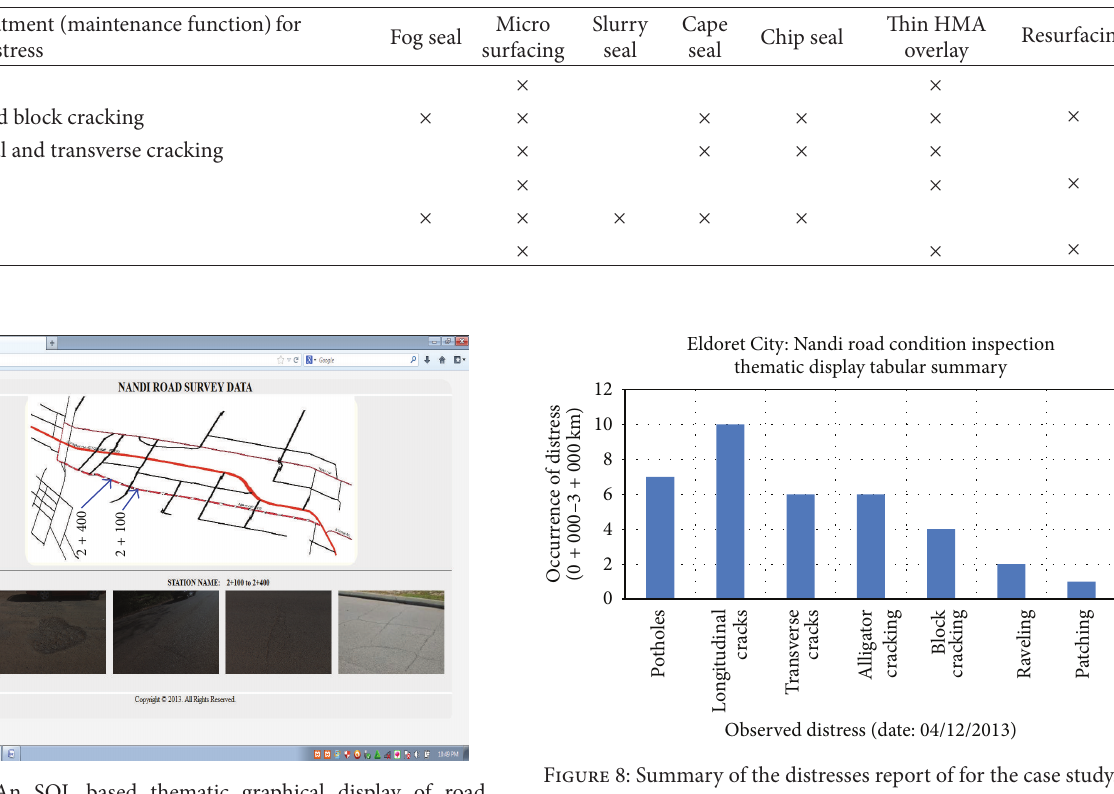
Table 4: Case study maintenance functions for the observed distresses.